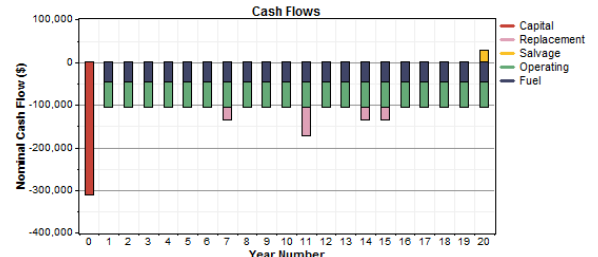
Figure 9: Cash flow for